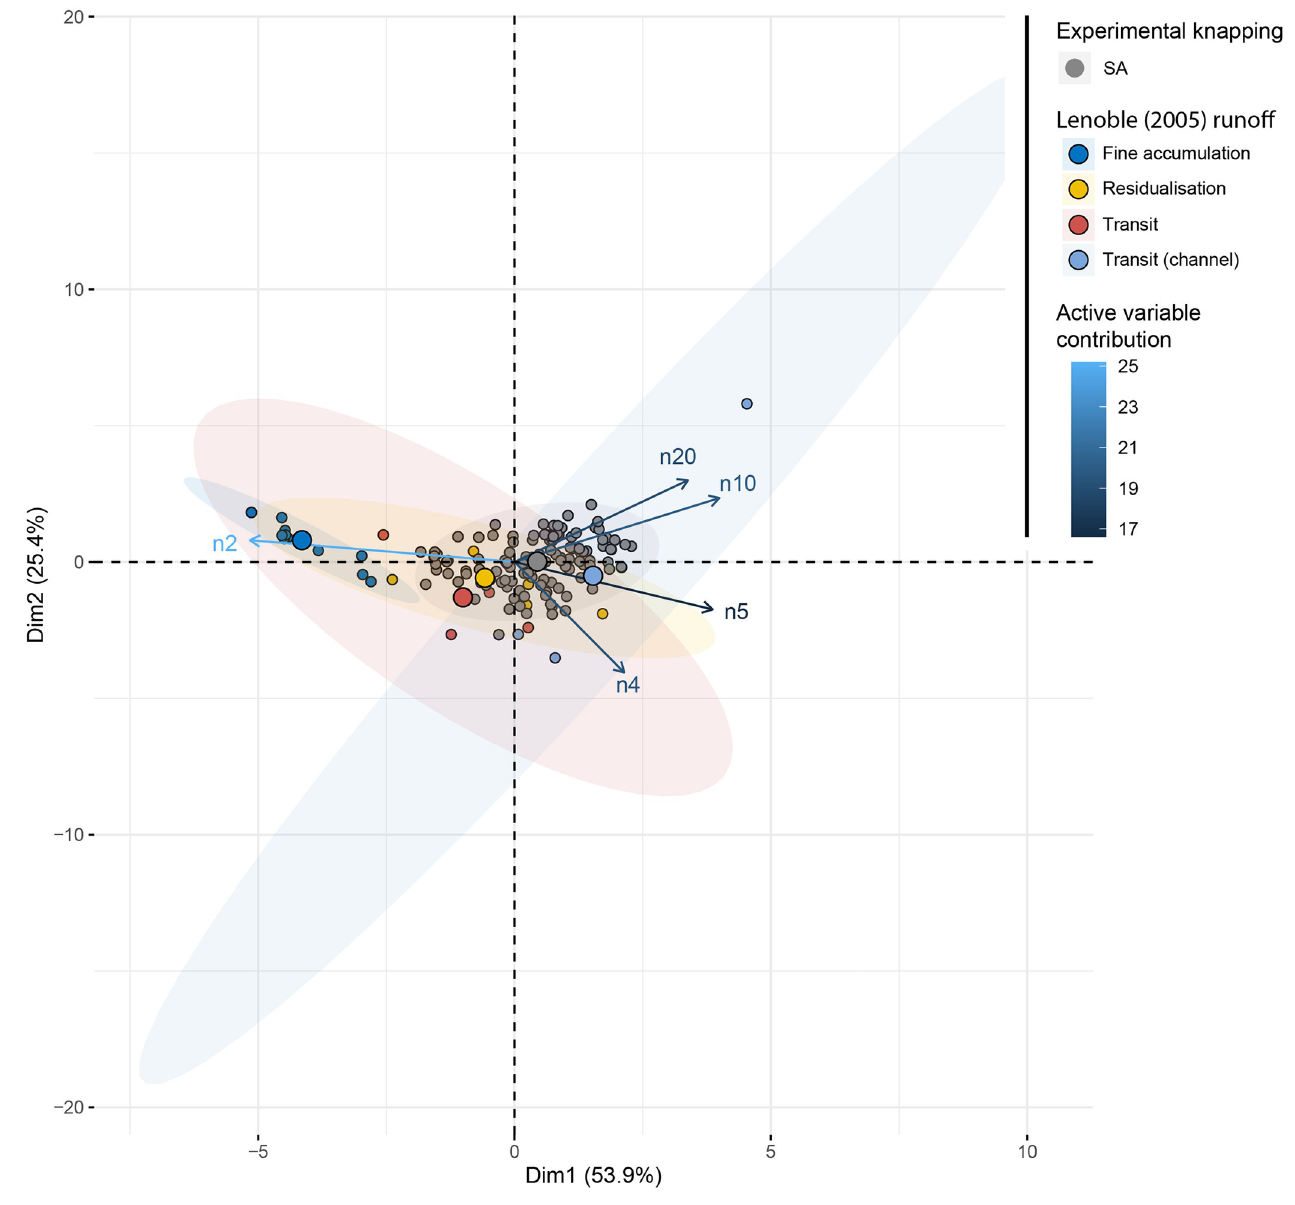
Fig 17. PCA comparing the SA dataset to the RUNOFF dataset